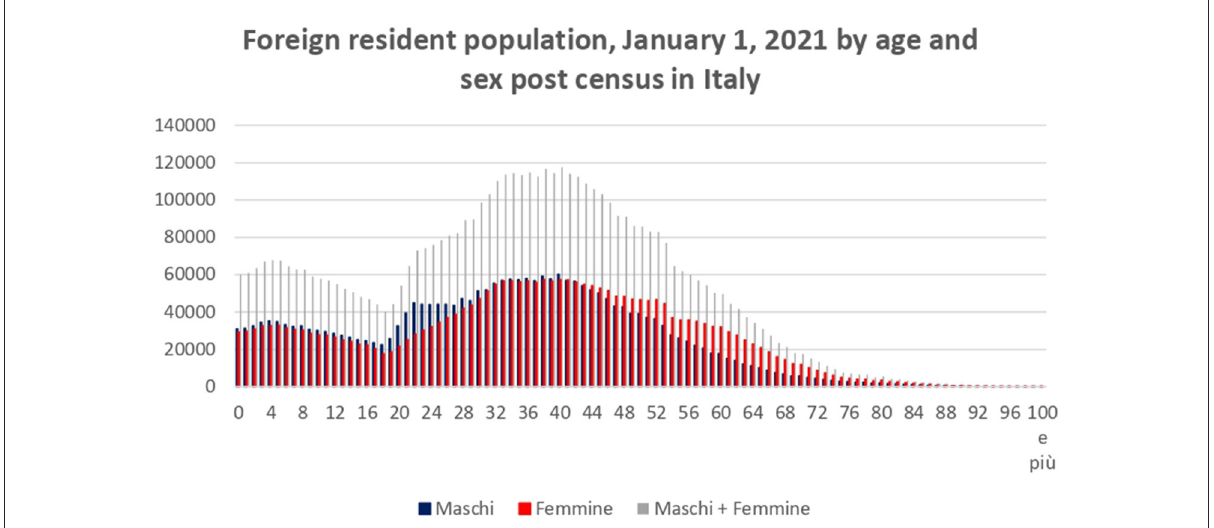
FIGURE1 Foreign resident population, Italy 2021. Personal elaboration on Demo Istat data